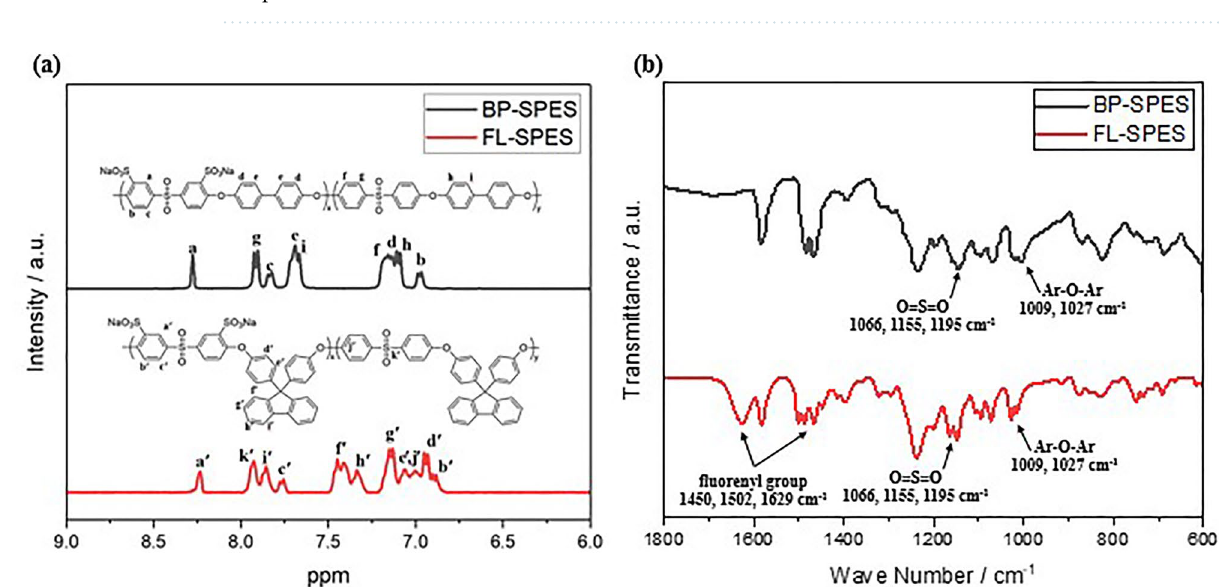
Figure 2. 1 H-NMR and FT-IR spectra of BP-SPES and